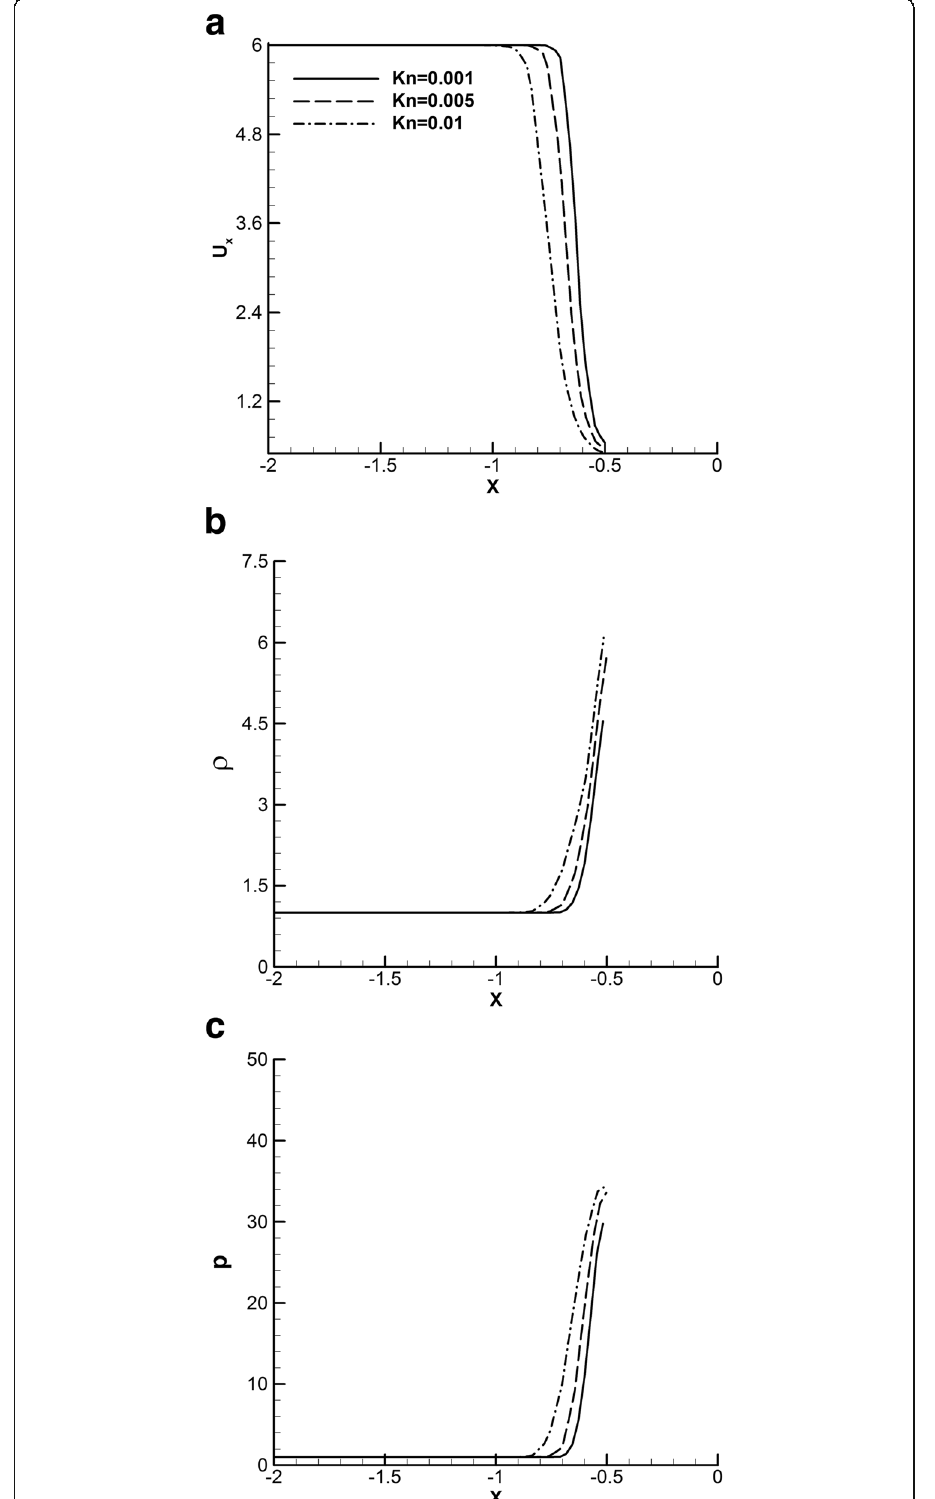
Fig. 18 Comparison of profiles of normalized conserved variables for different Knudsen numbers (0.001, 0.005, and 0.01) measured along the central axis line y = 0 at M = 6: a U x velocity, b density, and c